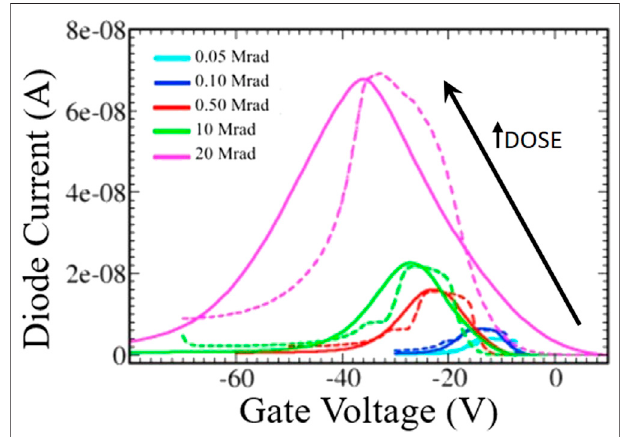
FIGURE 6 | I-V characteristics of n-on-p HPK gated-diode: comparison between the measured and simulated diode current as a function of gate voltage (no p-spray isolation layer).